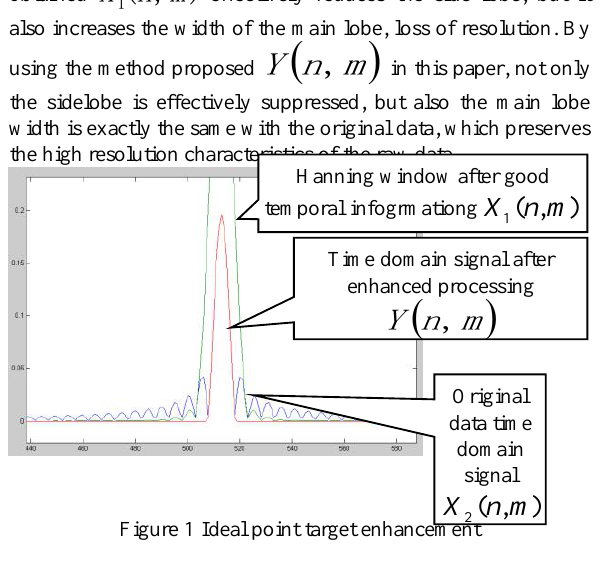
Figure 1 Ideal point target enhancement processing result diagram